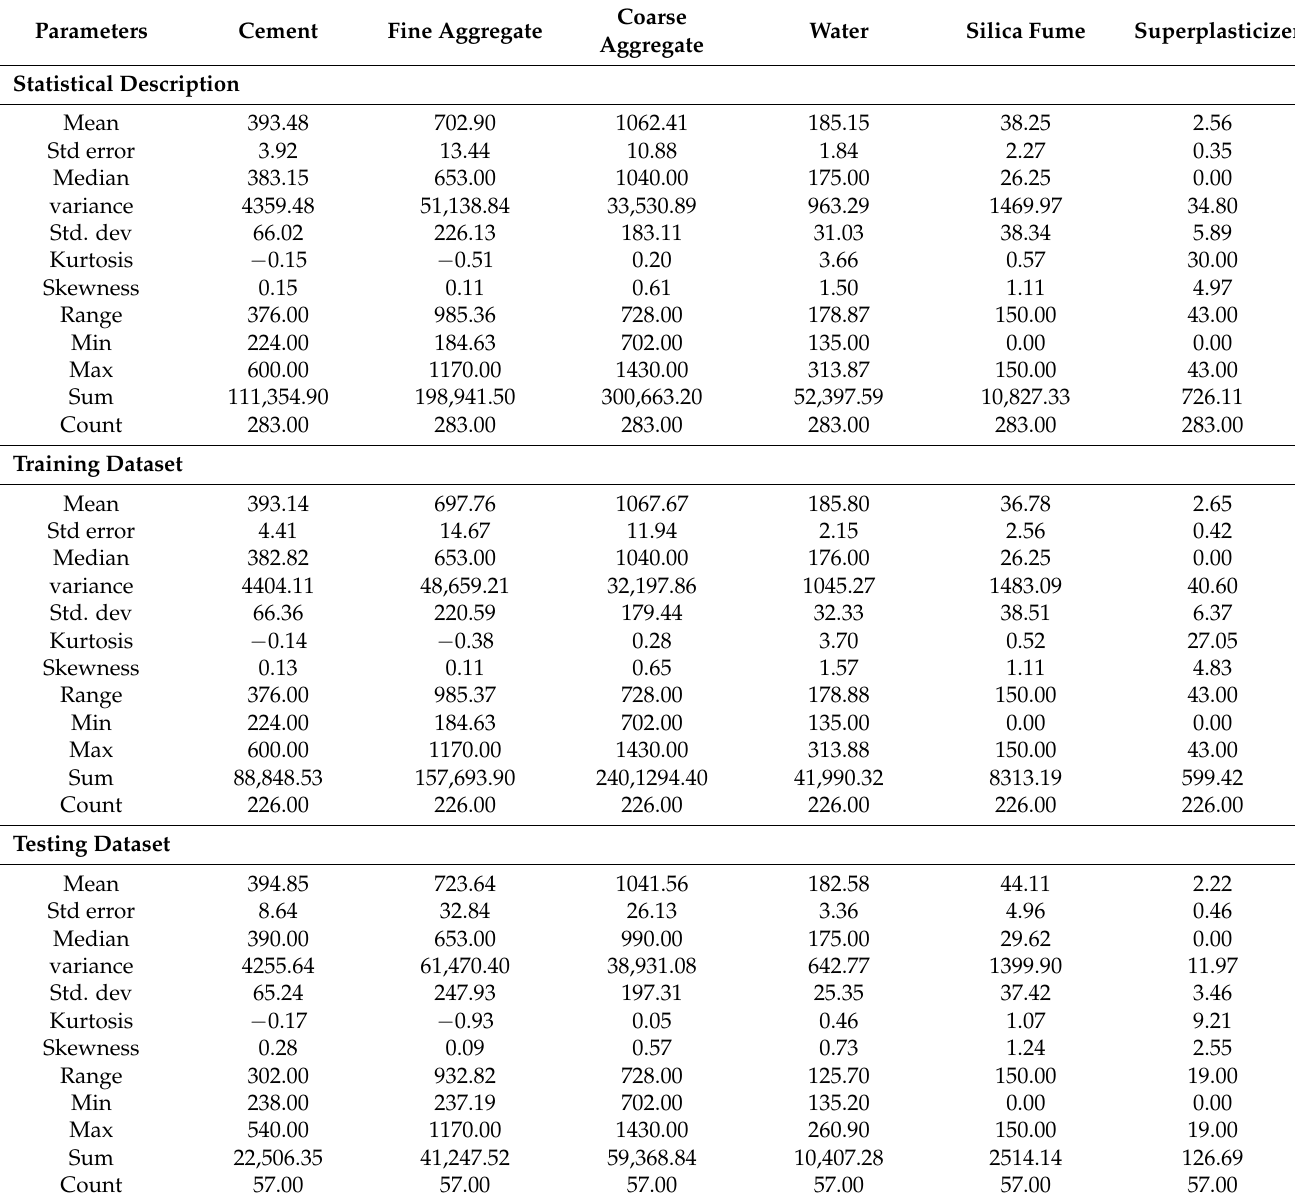
Table 2. Statistical Description of Data in the Model for Compressive Strength (Kg/m 3